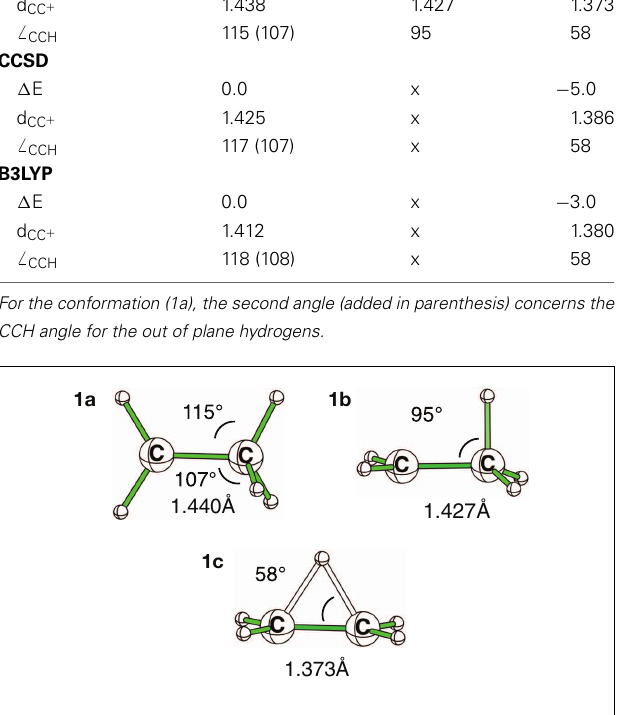
FIGURE 2 | HF/6-311G(d) optimized geometries for the three conformations of the ethyl